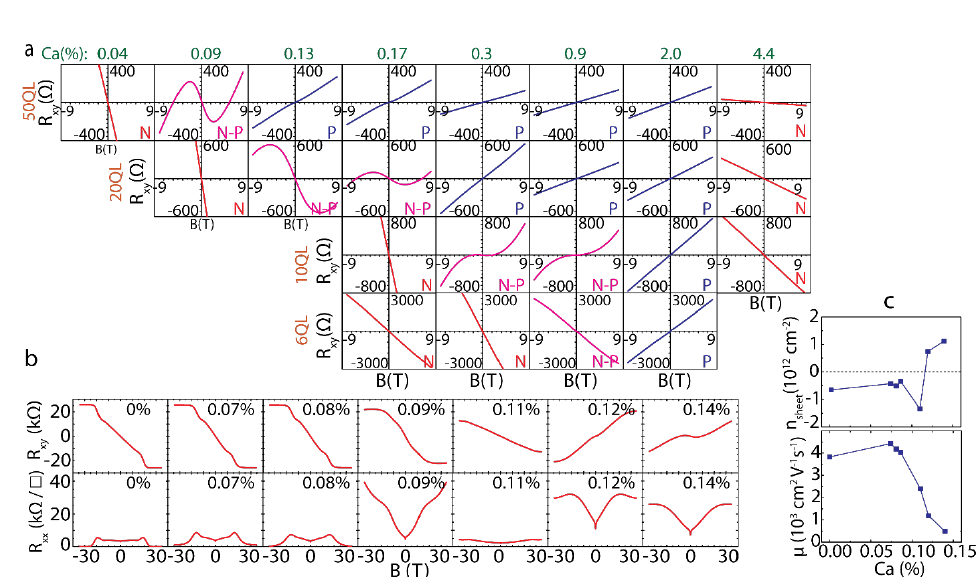
Se films . a, Magnetic Figure 7: Effect of Ca-doping on interface-engineered Bi 2 3 field-dependence of R of Ca-doped Bi Se (with Se cap) films for various Ca concen- xy 2 3 trations and different thicknesses. n-type (negative slope), p-type (positive slope), and non-linear n-p mixed curves are colored as red, blue, and pink, respectively. As Ca concentration increases, all the films transition from n- to p-type through an n-p mixed regime, and then eventually become n-type again except for the 6 QL film which becomes insulating, instead. b, Magnetic field-dependence of R and xy R and the evolution of QH in 8 QL-thick buffer-layer-based Bi Se films (capped xx 2 3 by MoO and Se) with different Ca doping at 300 mK. c, Extracted 2D sheet carrier 3 density ( n ) in top panel and mobility ( µ ) in bottom panel for different Ca doping sheet levels. µ sharply decreases when the carrier type changes from n- to p-type. All the figures are adapted from ref. [ 59